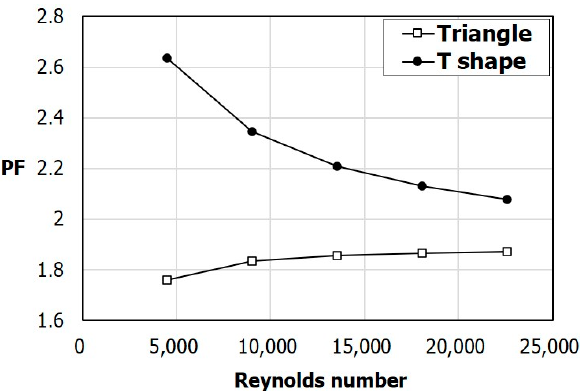
Figure 20. Comparison of PF between T-shaped and triangular ribs. Table 3. Comparison of performance factor range obtained in the present study with those obtained in the previous experimental or numerical studies on obstacle